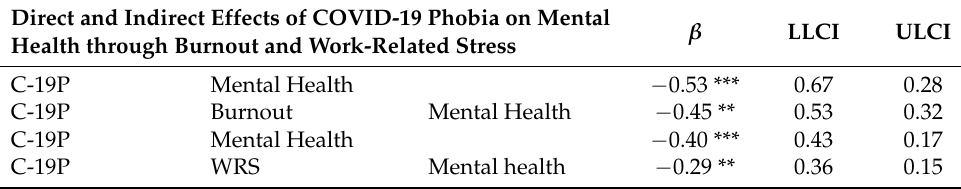
Table 5. Results for mediation